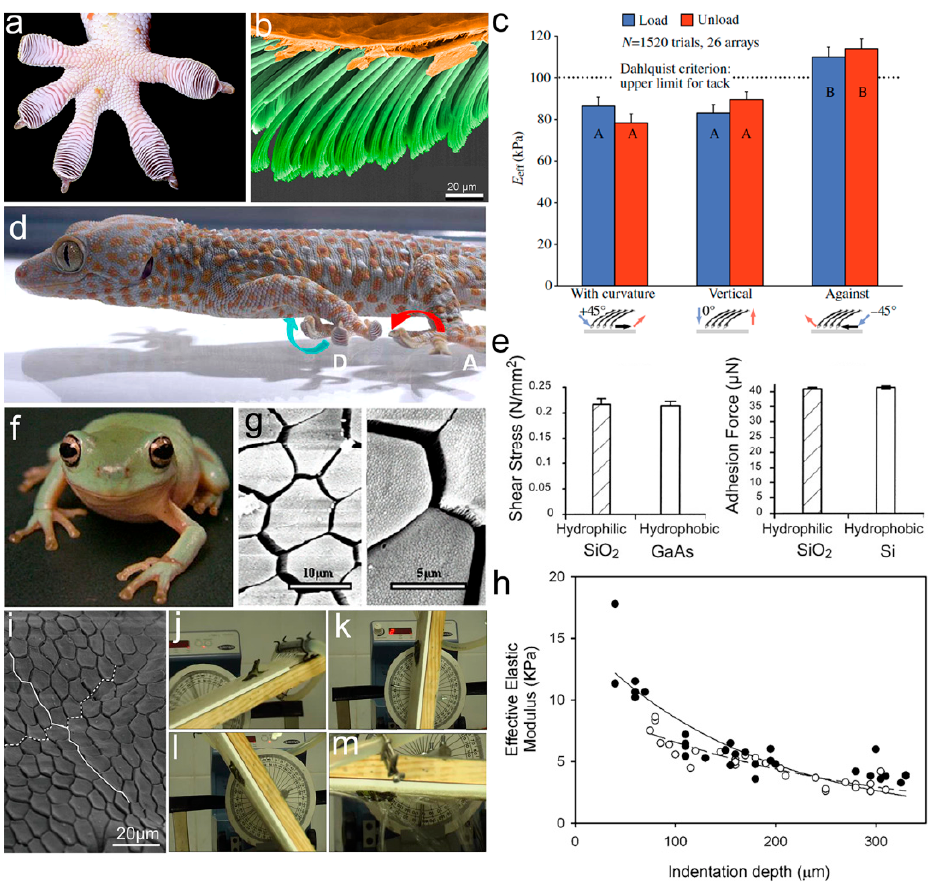
Figure 2. Hierarchical structured adhesives in nature. ( a ) Toe pad of tokay gecko. Reproduced with permission from [10]; ( b ) Scanning electron microscopy (SEM) image of gecko’s toe pad hierarchical structure of multi-level setae (green), supported by lamella (orange). Adapted with permission from [12]; ( c ) Effective elastic modulus ( E eff ) during deformation of isolated setal arrays on the gecko’s toe pad. Reproduced with permission from [10]; ( d ) Attachment (A) and detachment (D) processes of the gecko’s toe pad. Reproduced with permission from [40]; ( e ) The performance of gecko setae on hydrophilic SiO 2 and hydrophobic GaAs or Si surfaces. Reproduced with permission from [14]; ( f ) Immature White’s tree frog ( Litoria caerulea ); ( g ) SEM images of the toe pad of White’s tree frog at different magnifications. Reproduced with permission from [55]; ( h ) Effect of indentation depth on the effective elastic modulus of the tree frog smooth adhesive pad during indentation test. Open and filled circles represent data from two mature adult frogs. Reproduced with permission from [60]; ( i ) Elongated polygonal epithelial cells on the toe pad of the torrent frog ( Staurois guttatus ); ( j – m ) Adhesion performance of Staurois guttatus on the rotating platform, with an uneven surface under high flow velocity conditions. Reproduced with permission from